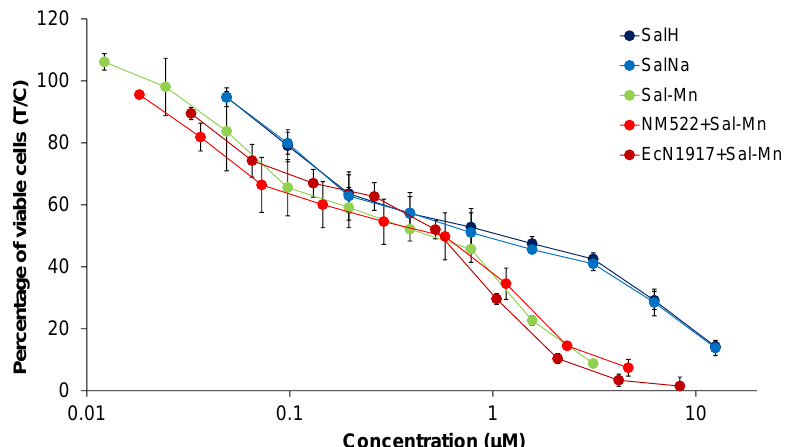
Figure 7. Concentration-effect curves of Sal-H, Sal-Na, Sal-Mn(II), NM522 + Sal-Mn(II), and EcN1917 + Sal-Mn(II) in A549 (top), CH1/PA-1 (middle), and SW480 (bottom) cells, determined by the MTT assay after 96 h treatment. Values are normalized relative to untreated controls and represent means and standard deviations of at least three independent experiments.